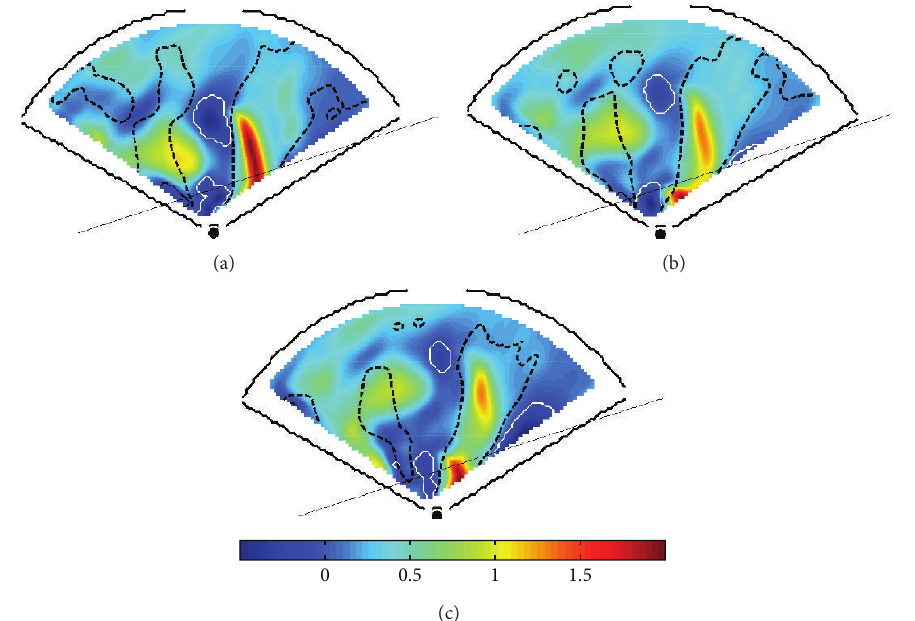
Figure 7: Evolution of an anticyclone depicted by the Lagrangian measure, around 1:50 pm on 15 August (Hong Kong time). (a)–(c) are shown in consecutive order by 20-second intervals. The color plots are the Lagrangian diagnostic, which show coherent vortices when the diagnostic is blow 0 (deformation tensor exhibits complex eigenvalues). The black contours show actual LIDAR coverage. The dashed black contours separate regions of different rotation direction, irrespective of whether vorticity dominates strain. The white isocontours enclose regions with anticyclones; that is, these regions are vorticity dominant and rotate in the clockwise direction. The black straight lines indicate 25RA. In this event, anticyclones pinch off from around the LIDAR and move northwards, whereas new anticyclone patches pinch off across the